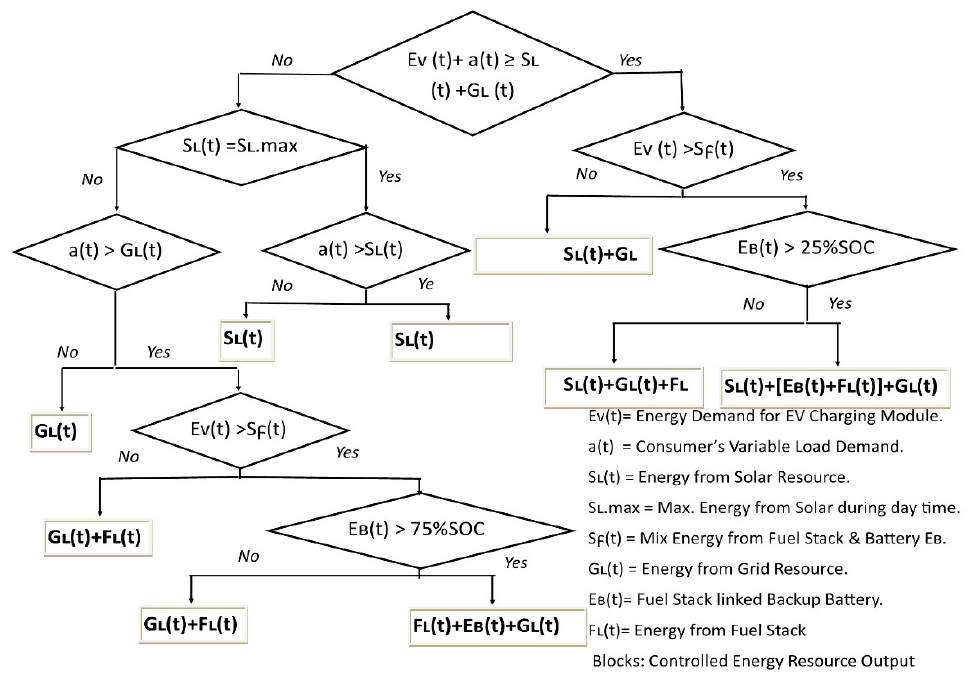
Figure 3. Energy Resource Management Algorithm.